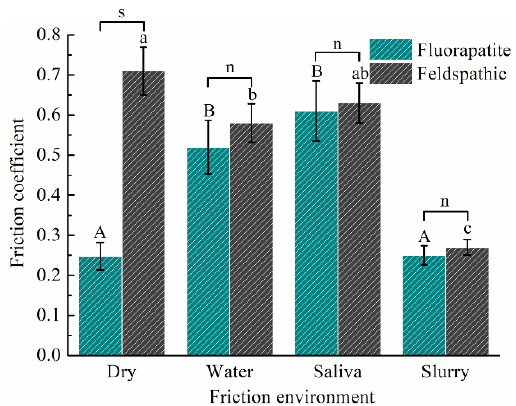
Figure 2. Average coe ffi cients of the two ceramics in dry friction, saliva, water, and slurry conditions. s (Significant) and n (not significant) refers to the Tukey’s HSD test results between the two types of specimens in the same environment ( α = 0.05). Same uppercase letters (fluorapatite) or lowercase (feldspathic) letters represent no significant di ff erences among values of the same material in di ff erent environments ( p > 0.05).